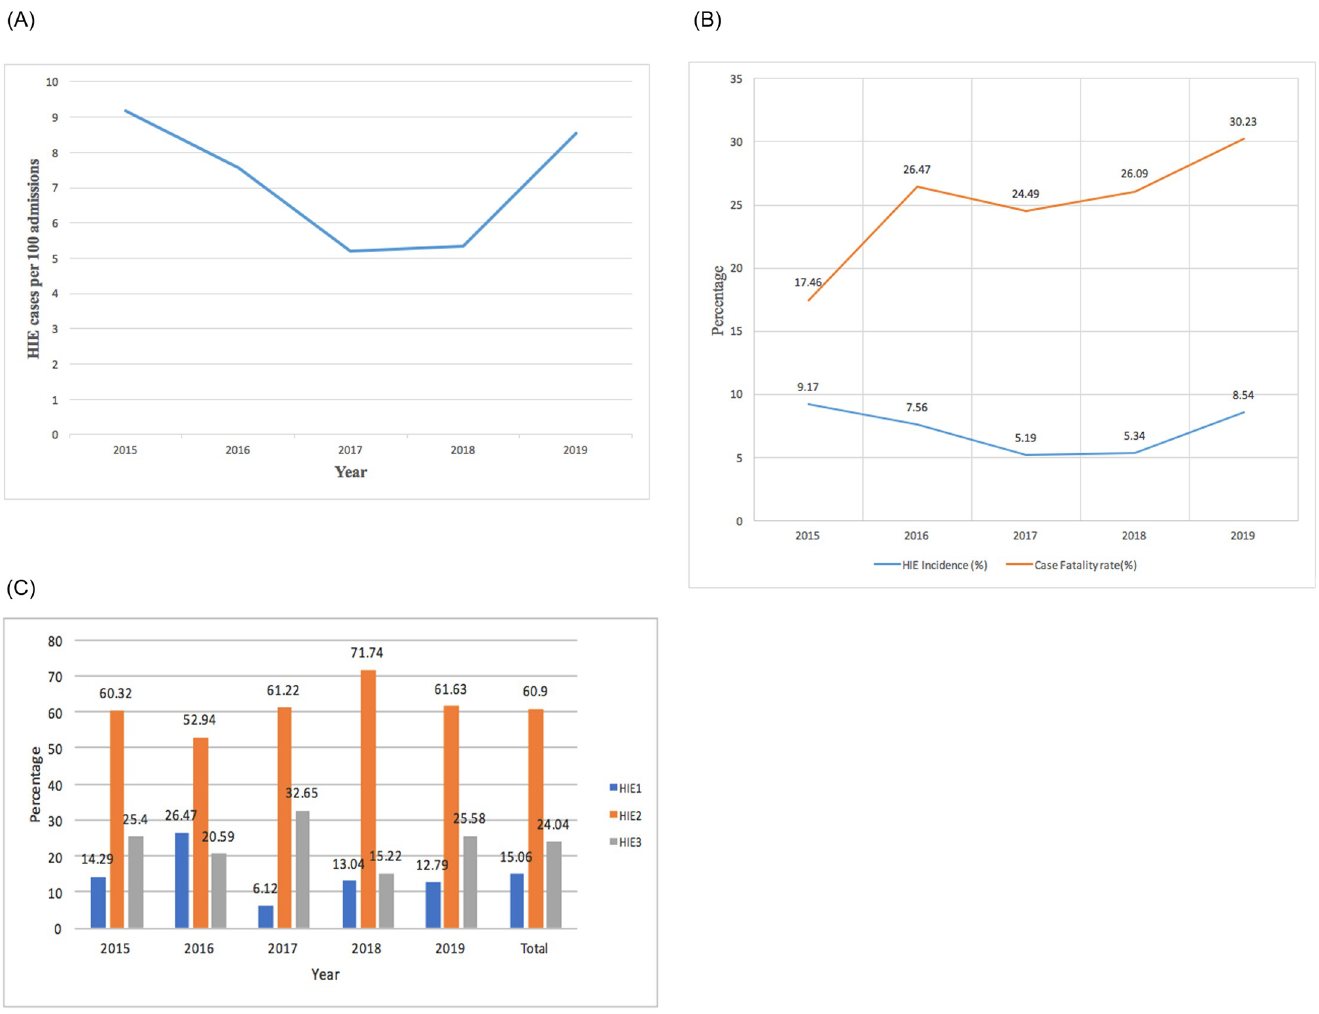
Fig 1. A. Trends in HIE admission. B. Trends in incidence and fatality rate for HIE (2015–2019). C. Trends in severity of admitted cases of HIE